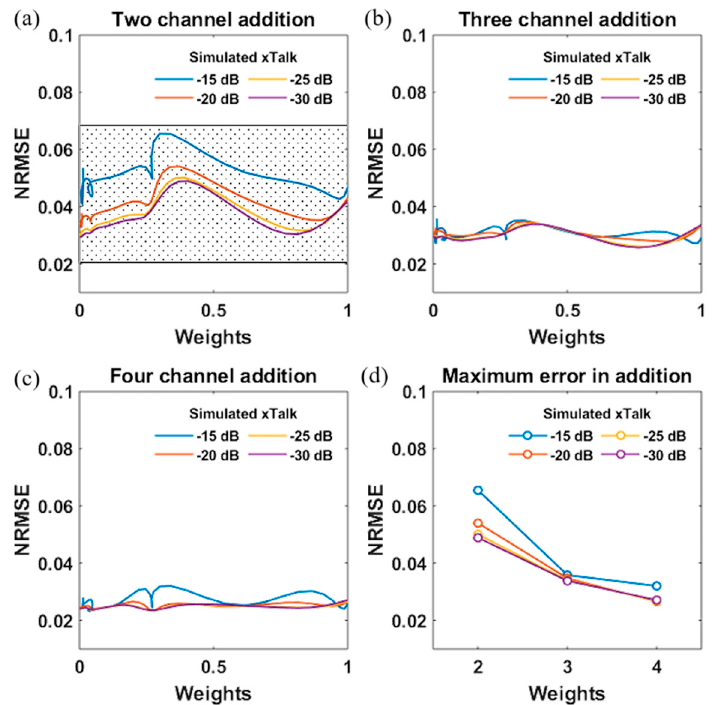
Figure 4. ( a ) Two-channel weighted addition, ( b ) three-channel addition, and ( c ) four-channel addition when tuning weights in channel 1 and fixed weight on other channels; ( d ) Maximum error versus the number of channels in weighted addition. Optical crosstalk levels are − 15 dB (blue), − 20 dB (red), − 25 dB (yellow) and − 30 dB (violet).